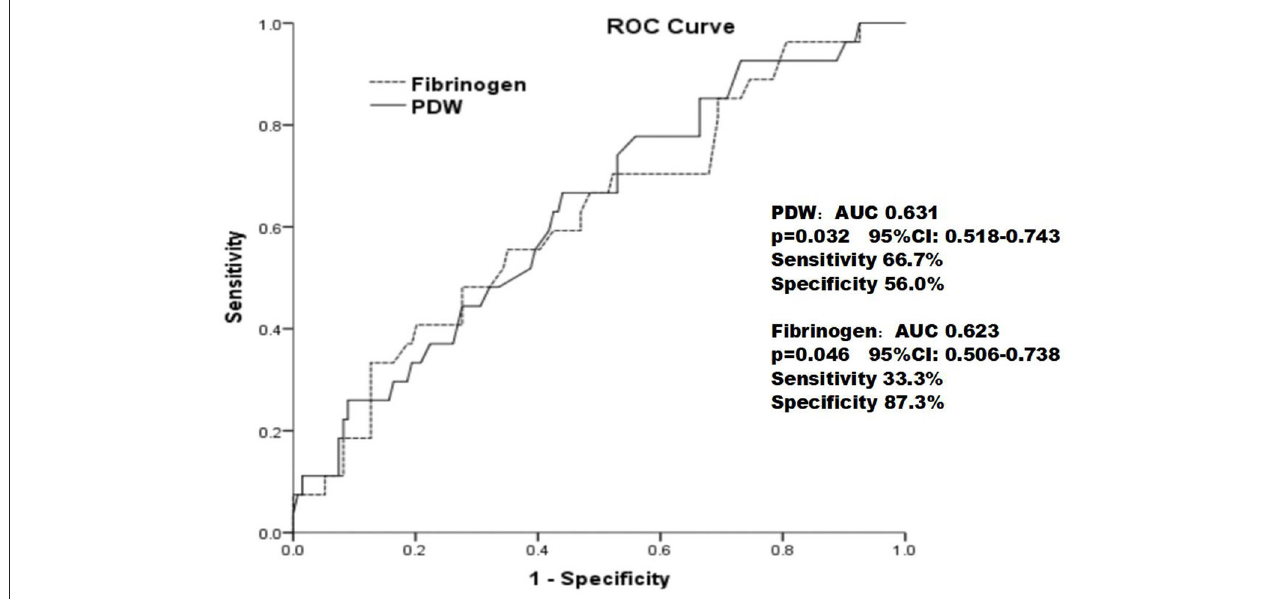
FIGURE 3 | The receiver operating characteristic curve of the PDW and fibrinogen in predicting in-stent restenosis in patients with type 2 diabetes mellitus who underwent drug-eluting stent implantation.